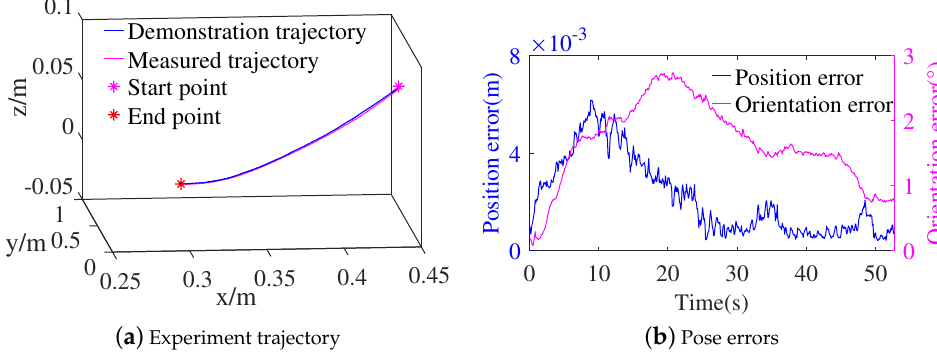
Figure 8. Experiment trajectory and pose errors of robot moving from the contact space under no interactions.